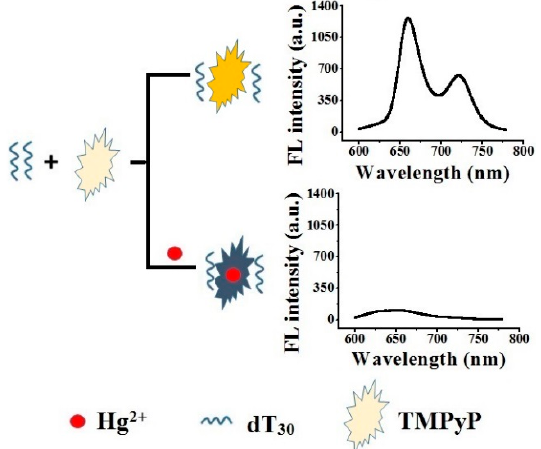
Figure 1. Schematic of Hg 2+ assay by quenching the fluorescence of TMPyP-dT 30